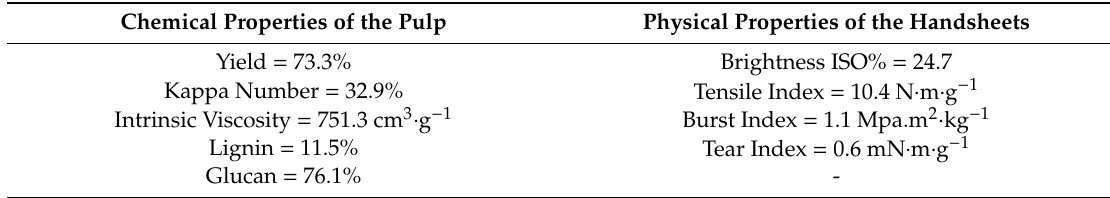
Table 4. Chemical characterization of pulp and physical properties of paper sheets obtained from pulp after autohydrolysis and enzymatic